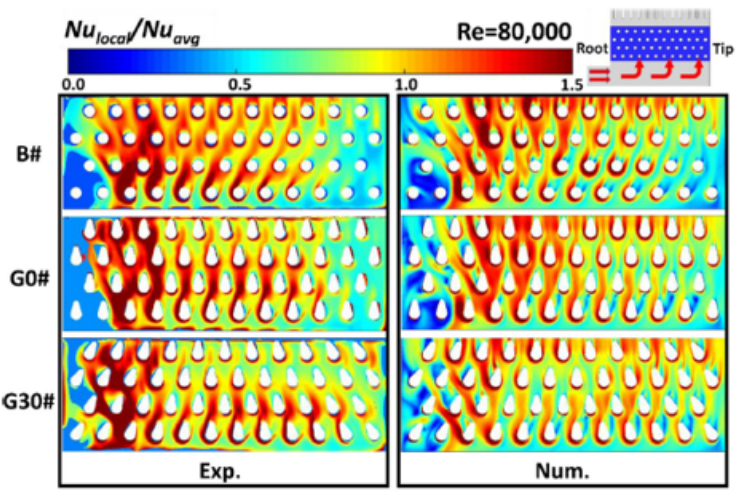
Figure 8. Normalized local Nusselt number ratio at Re = 80,000 [89]. Reprinted with permission: License number